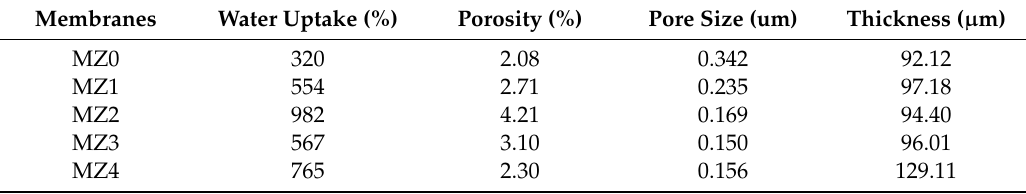
Figure 7. Variation of water contact angle with zwitterion content in the prepared membranes. Table 2. Calculated water uptake and porosity as well as measured membrane thickness and pore sizes. Membranes Water Uptake (%) Porosity (%) Pore Size